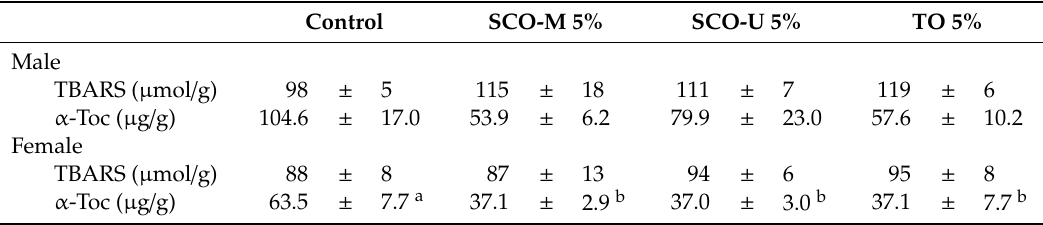
Table 5. Liver thiobarbituric acid reactive substances (TBARS) and α -tocopherol ( α -Toc) levels in mice administered with scallop oil for 13